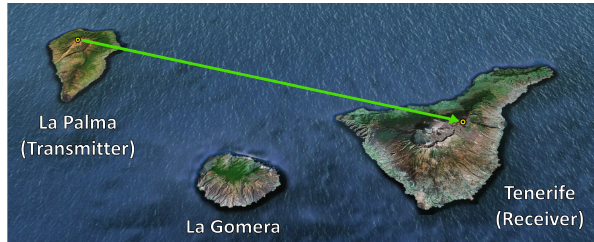
Fig. 1. Illustration of the laser link between the Canary Islands La Palma and Tenerife (map area ∼ 28 ◦ N to ∼ 29 ◦ N, ∼ 18 ◦ W to ∼ 16 ◦ W). Image 2012 Google© 2012 TerraMetrics© and